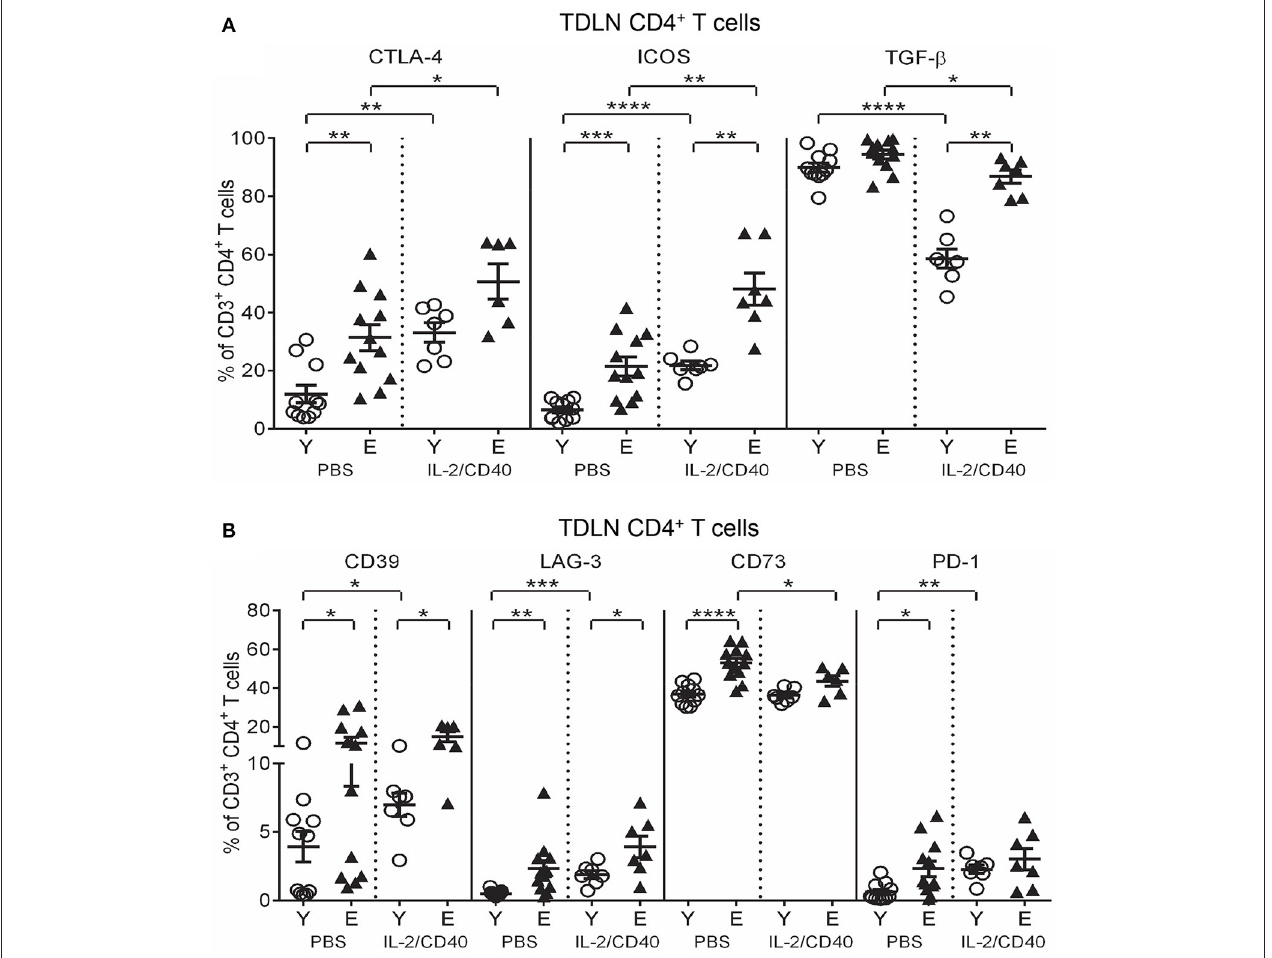
FIGURE 8 | IL-2/CD40 increases CTLA-4, ICOS, TGF- β , CD39, and LAG-3 on young and elderly TDLN CD4 + T cells. After two doses of IL-2/CD40 or PBS diluent, percentages of CD4 + T cells positive for CTLA-4, ICOS and TGF- β (A) and CD39, LAG-3, CD73, and PD-1 (B) were measured in TDLNs from the young and elderly tumor-bearing mice described in Figures 5B,C using flow cytometry. Data are shown as mean ± SEM, n = 7 young and n = 6–7 elderly IL-2/CD40-treated mice, n = 11 young and n = 12 elderly PBS control mice, * p < 0.05, ** p < 0.005, *** p < 0.0005, **** p < 0.0001 comparing (i) young to elderly mice, or (ii) IL-2/CD40-treated mice to age-matched PBS control